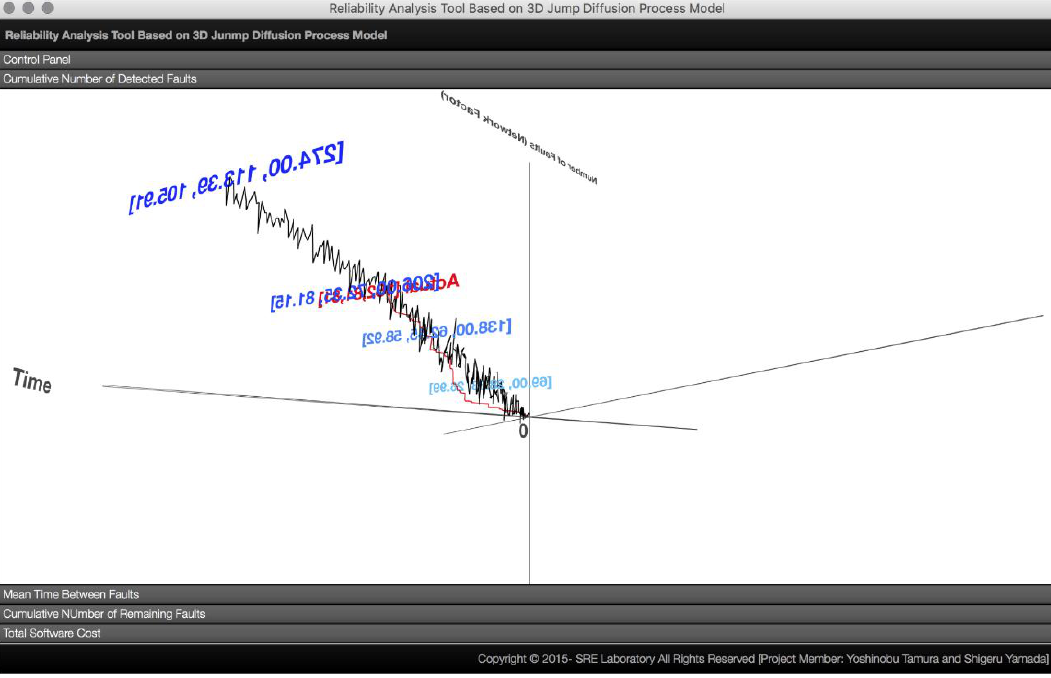
Fig. 2. The sample path of the estimated cumulative number of detected faults